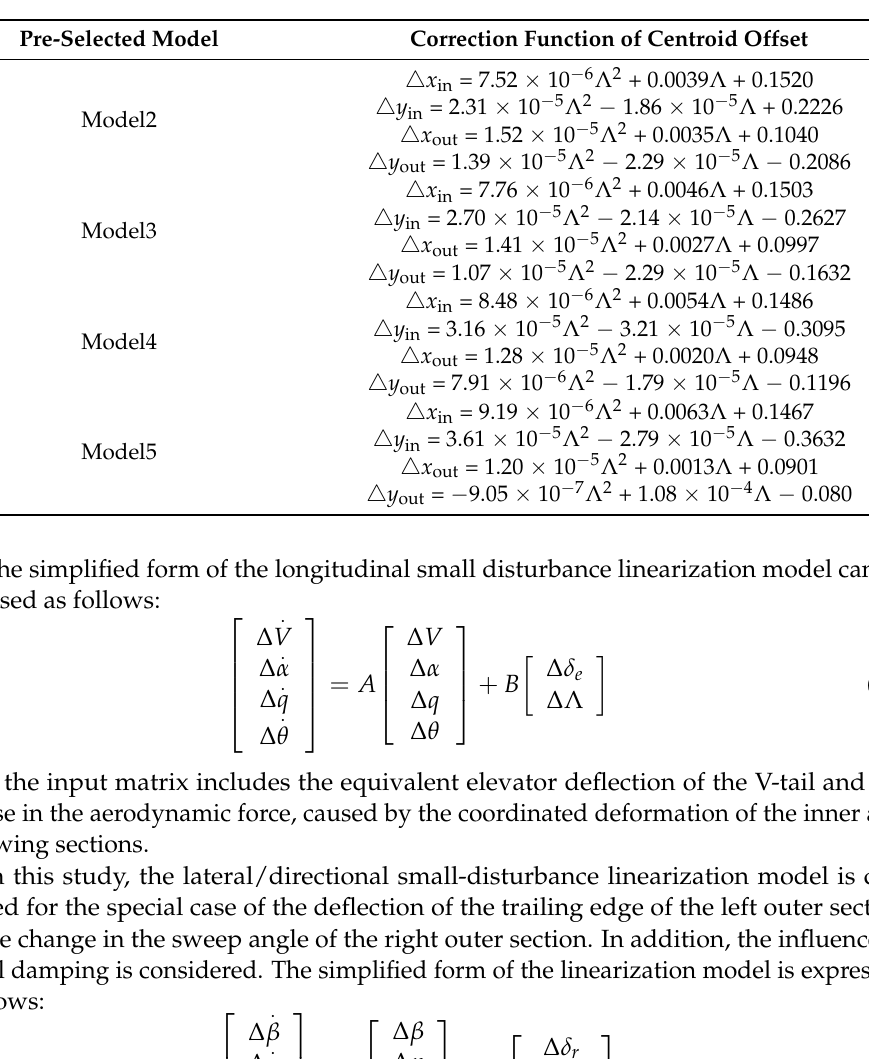
Table 7. The modification functions of the centroid offset of pre-selected model sections considering the actual